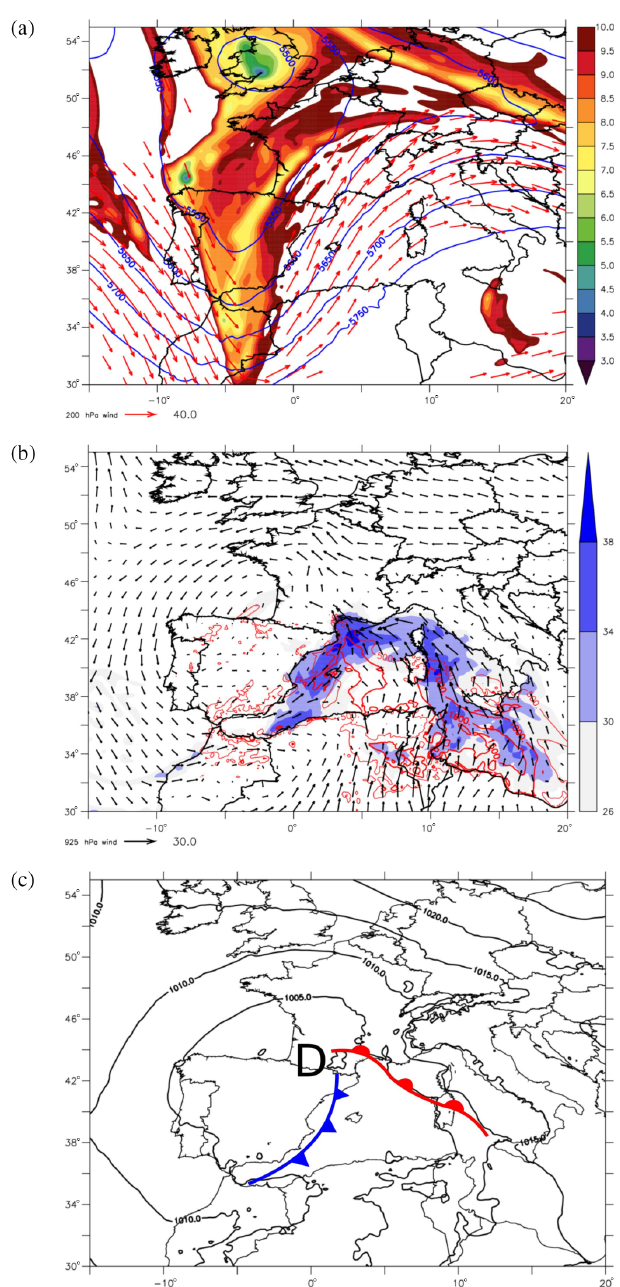
Figure 3. Synoptic situation at 12:00UTC on 13 October 2016 from the ARPEGE analysis (a) at high level: the coloured shading is the height of the 2PVU (potential vorticity units) isosurface (km), the blue contours are the geopotential height (m) at 500hPa and the red arrows denote the wind above 20ms − 1 at 200hPa. Synoptic situa- tion at 12:00UTC on 13 October 2016 from the ARPEGE analysis (b) at low level: the coloured shading is the integrating water vapour (kgm − 2 ), the red contours are the convective available potential energy (Jkg − 1 ) and the black arrows denote the wind at 925hPa. Panel (c) shows the mean sea level pressure (black contours) and position of the cold (blue) and warm (red)